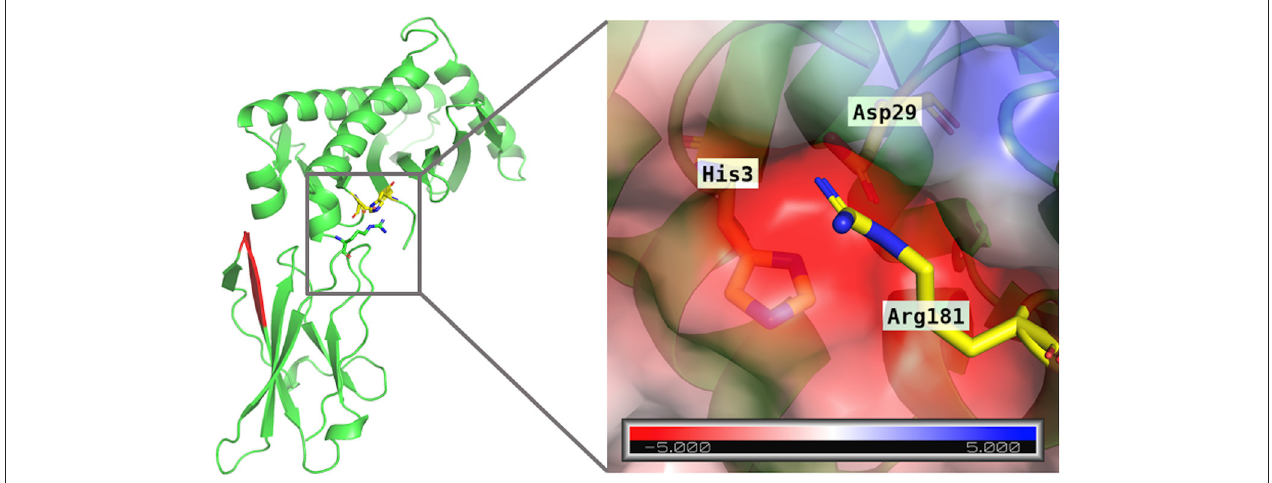
FIGURE 5 | Electrostatic potential map for the crevice formed by residues His3 and Asp29 (yellow sticks) on MICA. The electrostatic potential map is given in kT/e